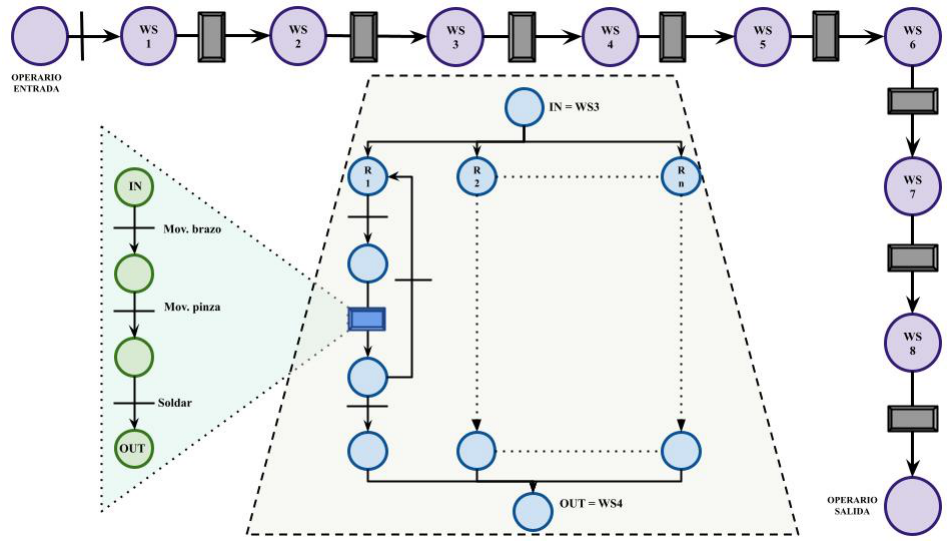
Figure 9. Hierarchical Petri net of the 8XY